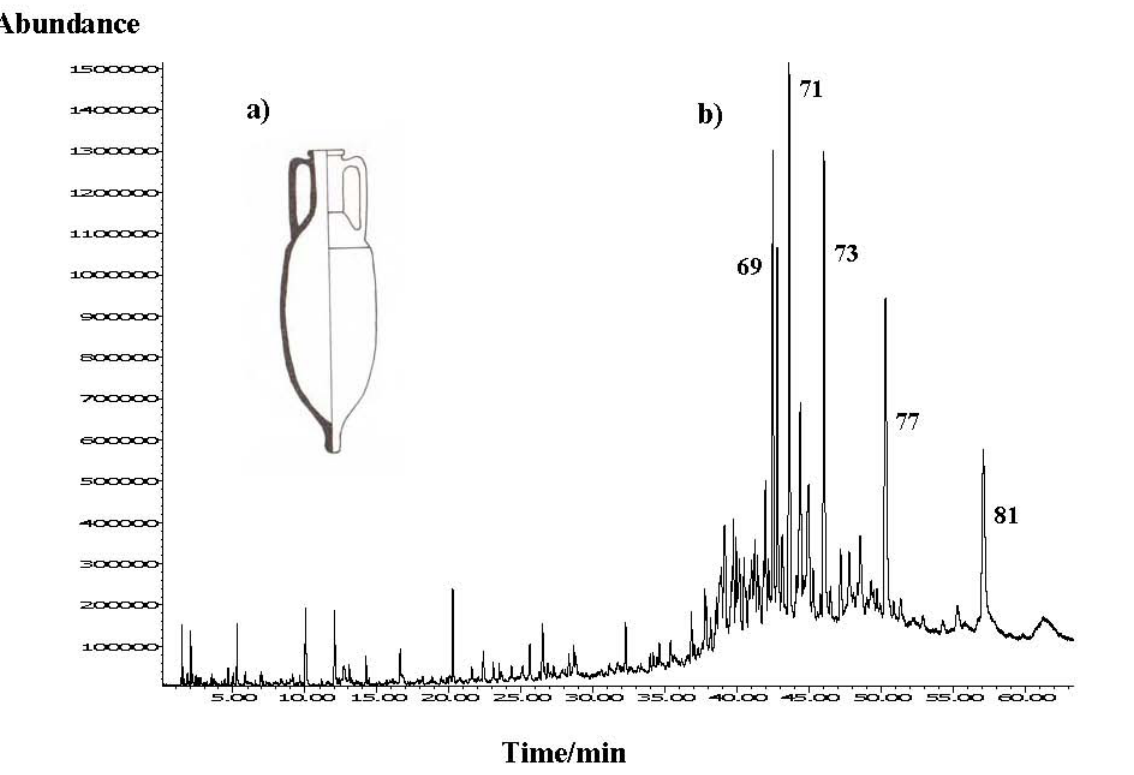
Figure 1. ( a ) Scheme of the Greco-Italian amphora type Benoit Republicane-II/Lamboglia with the section representing the coating. ( b ) Total ion chromatogram of the organic residue headspace composition obtained by HS-SPME (DVB/CAR/PDMS fibre) on HP-5MS column. Numbers refer to Table